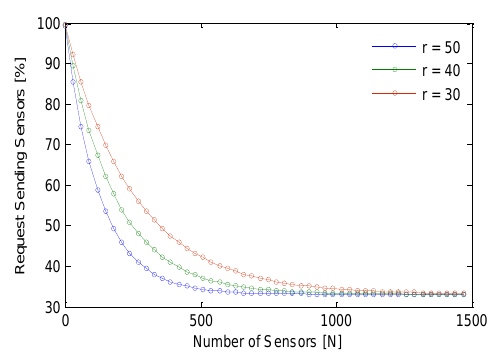
Figure 11. Requesting sensor % convergence in GS-IoT.